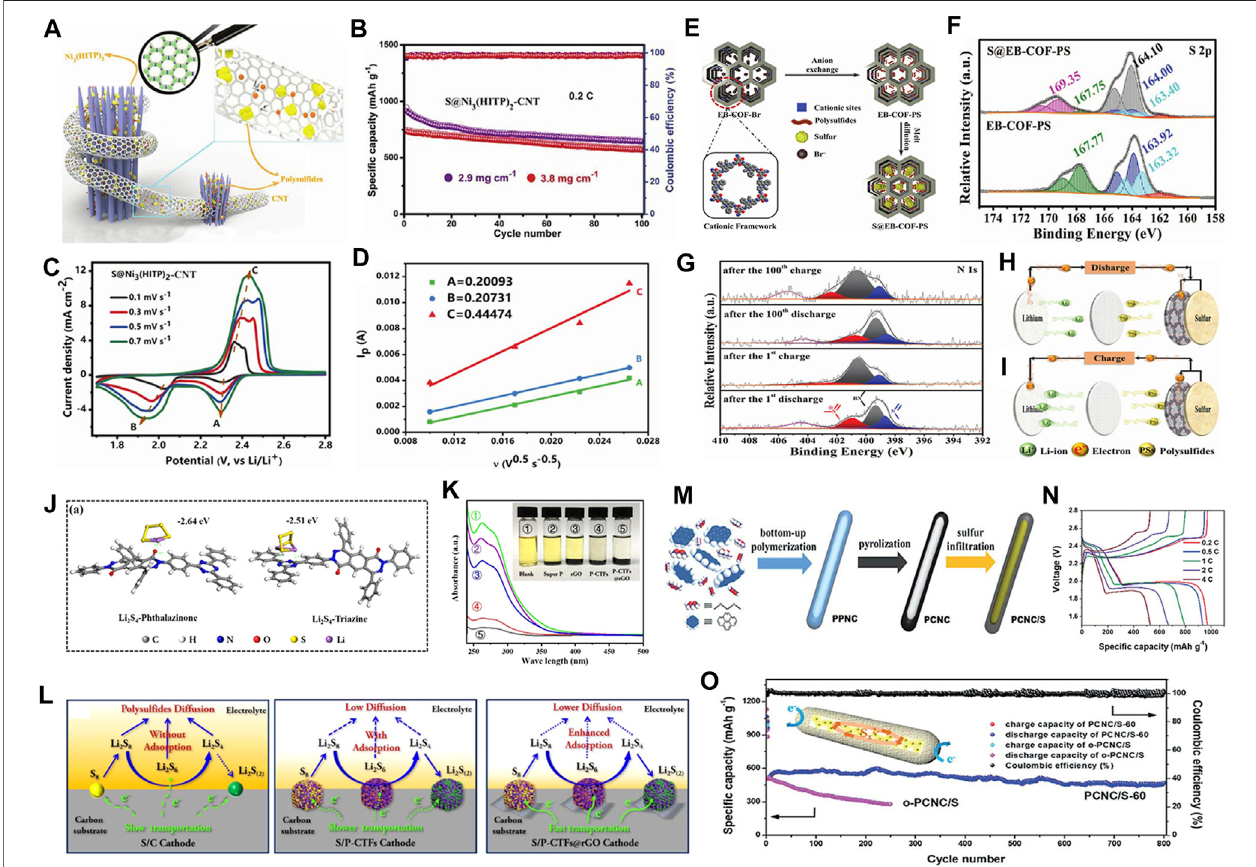
FIGURE 1 | Illustrations of organic electrocatalysts for sulfur hosts. (A) Synergistic effects of Ni 3 (HITP) 2 and CNT on Li − S batteries. The enlarged image is the crystallineofNi 3 (HITP) 2 . (B) CyclingperformanceofS@Ni 3 (HITP) 2 -CNTcathodesatsulfurloadingsof2.9and3.8 mgcm − 2 under0.2 C. (C) CVpro fi lesofS@Ni 3 (HITP) 2 - CNTatvariousscanrates. (D) The fi ttedLi + diffusioncoef fi cientofS@Ni 3 (HITP) 2 -CNTatdifferentredoxpeakswhichindicatestheimprovementofdynamicperformance by synergistic effects of Ni 3 (HITP) 2 and CNTs. (A – D) Figure reproduced from the data in Cai et al. (2019). (E) A schematic diagram of the synthesis of S@EB-COF- PS. (F) S 2p XPS spectra of EB-COF-PS and S@EB-COF-PS. (G) N 1s XPS spectra of S@EB-COF-PS after 1 and 100 cycles of charge/discharge. (H – I) Illustrations